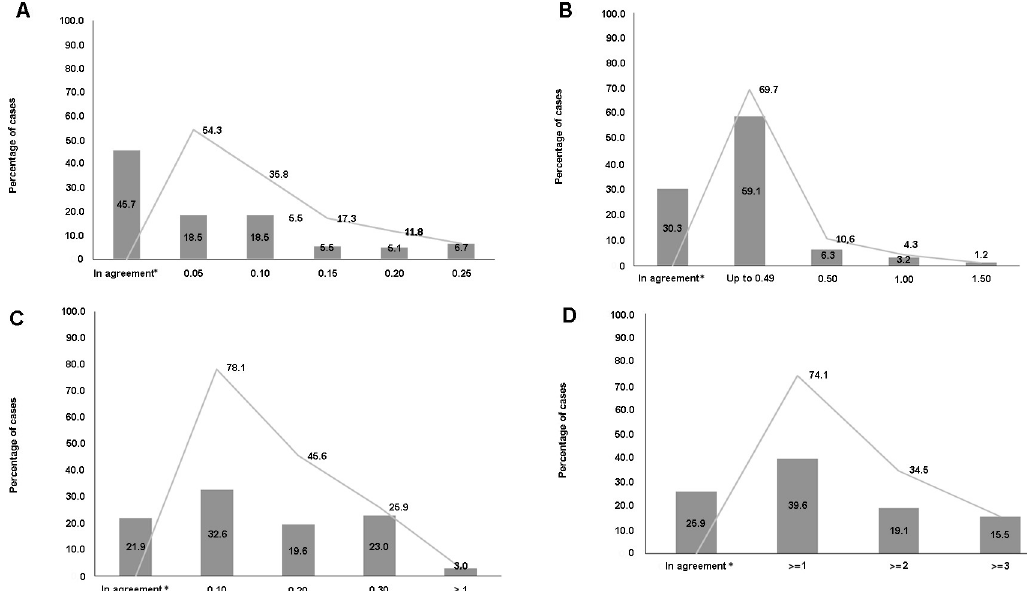
Fig 2. Percentage disagreement between doctor and nursing technicians for: A) Visual acuity, in logMAR; B) Autorefraction spherical equivalent (M), in diopters; C) Keratometry, in diopters; and D) Intraocular pressure, in mmHg.